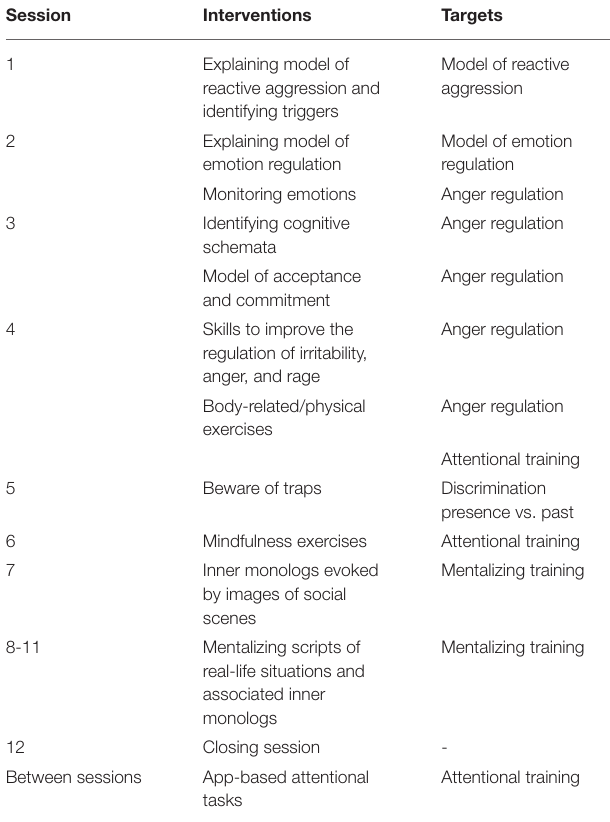
TABLE 2 | Overview of interventions and respective targets of group therapy sessions of